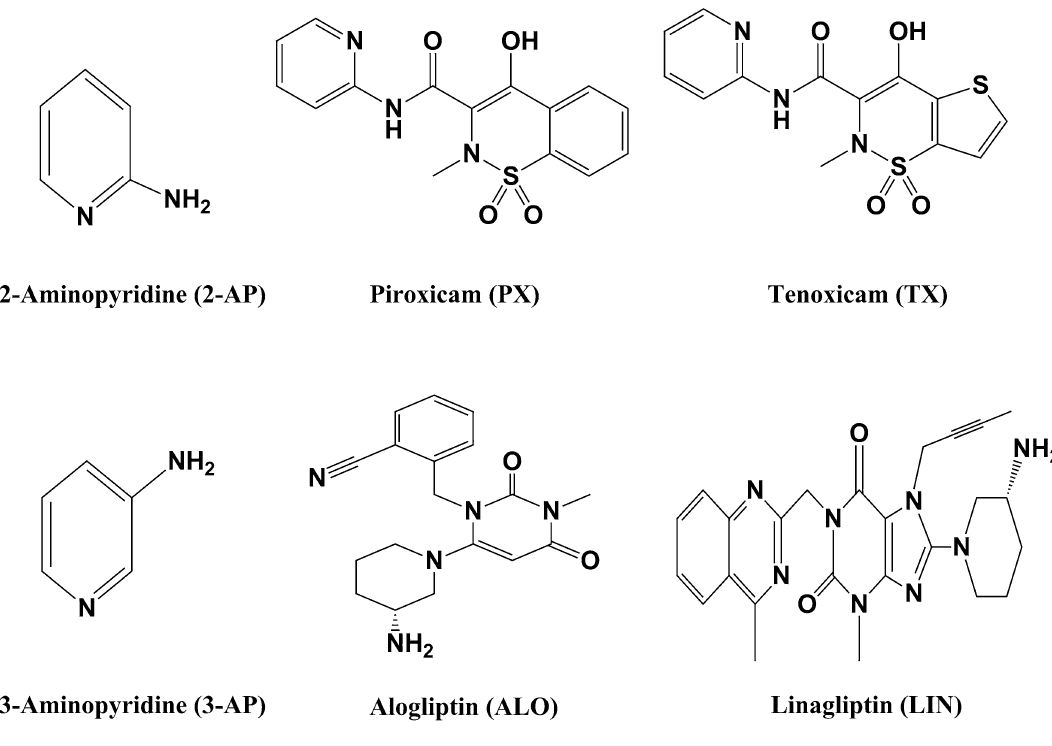
Figure 1. Analytes and drug compounds structures.